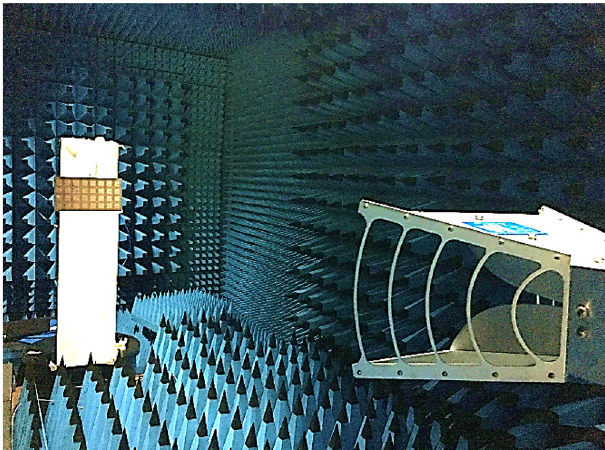
Figure 19. Setup of the radiation pattern for